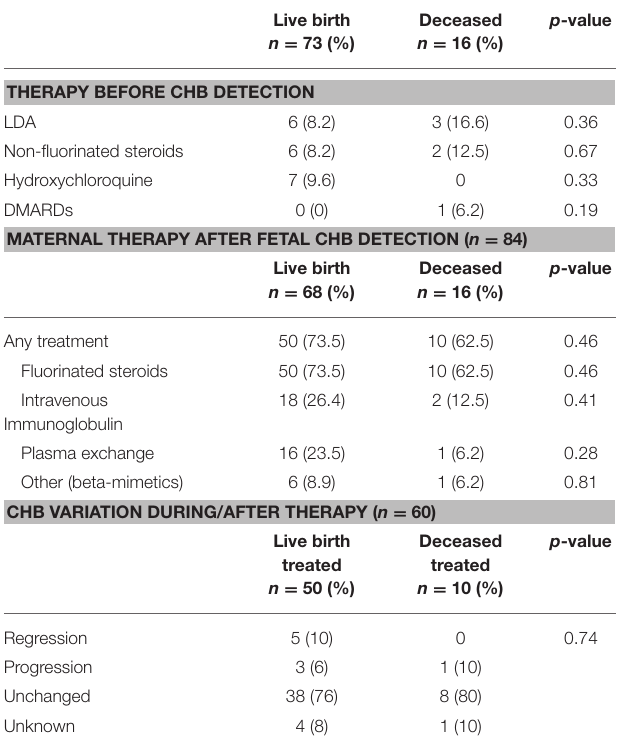
TABLE 4 | Comparison of clinical and demographic features among children born alive and fetuses died in utero .